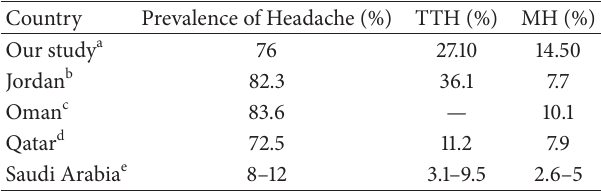
Table 4: Approach to medication use among headache patients. Table 5: Prevalence of TTH and MH in Arab